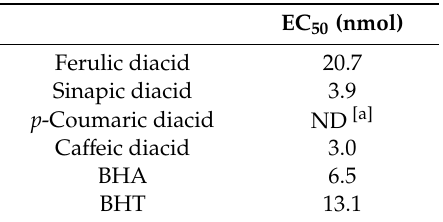
Table 7. Antiradical activities.